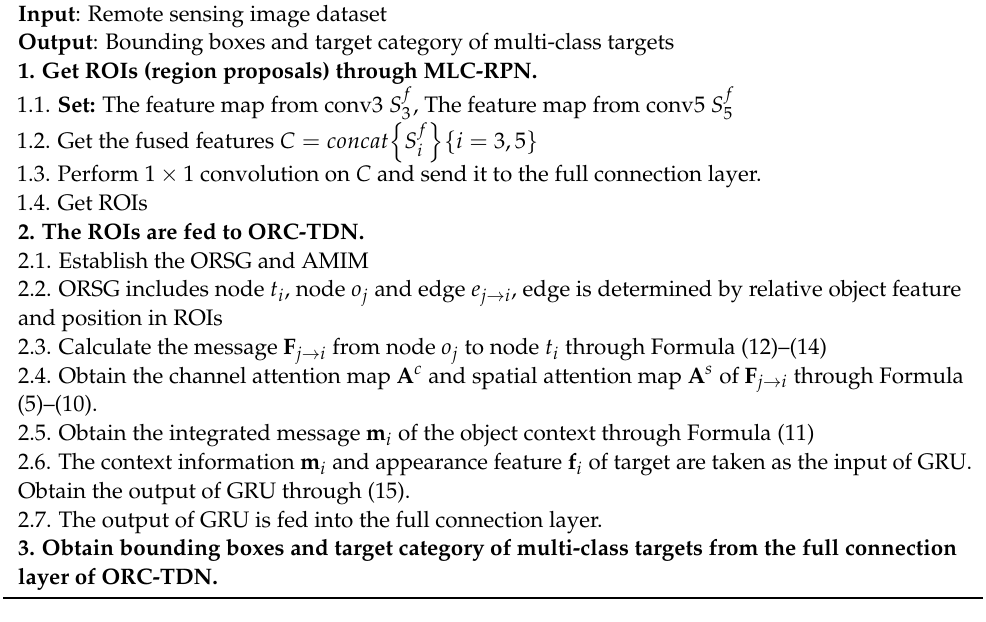
Algorithm 1 : The target detection method for remote sensing images based on structured object-level relational